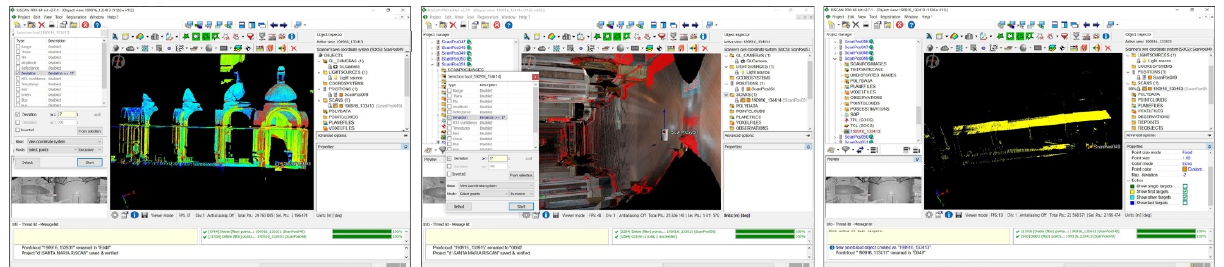
Figure 6. Automated filtering of the point cloud in the RiscanPRO software based on reflectance values and echo